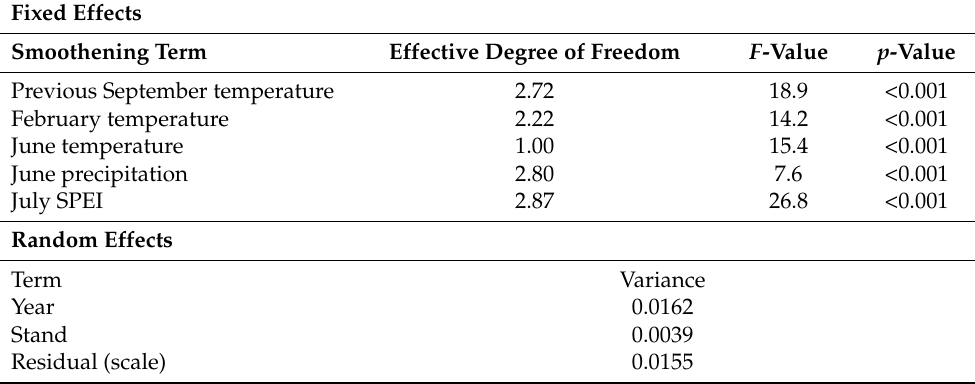
Table 4. Statistics of smoothing splines of the generalized additive mixed model of the relationships between the relative additional radial increment (tree-ring index) of Norway spruce from the Eastern Baltic region and meteorological variables: month mean temperature, precipitation, and precipitation evapotranspiration index (SPEI) during the 1954–2017